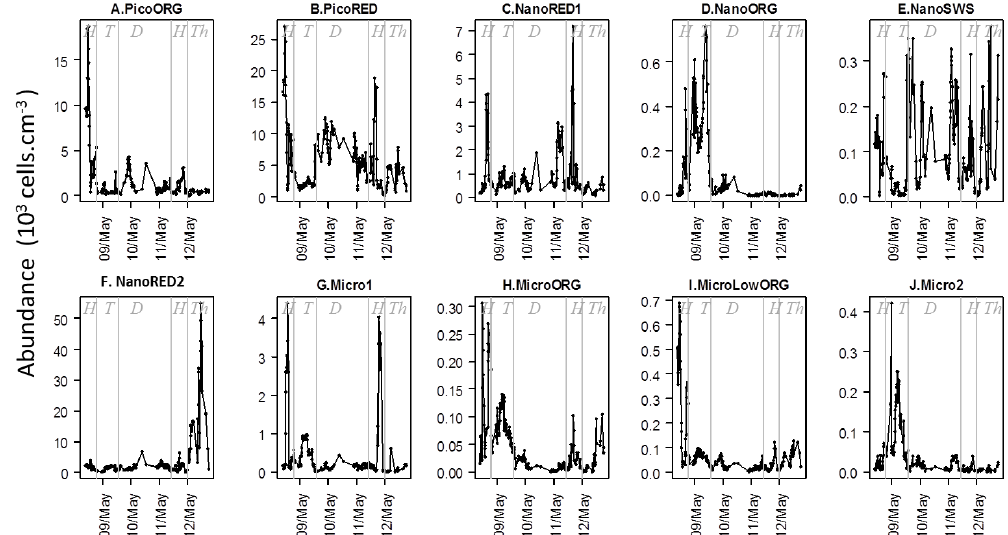
Figure 5. Abundance (10 3 cellscm − 3 ) of each phytoplankton cluster resolved with the scanning flow cytometer. In order to show evidence of distribution, scales have not been homogenized. Grey bars separate the traversed marine areas: H, Humber; T, Tyne; D, Dogger; Th, Thames.